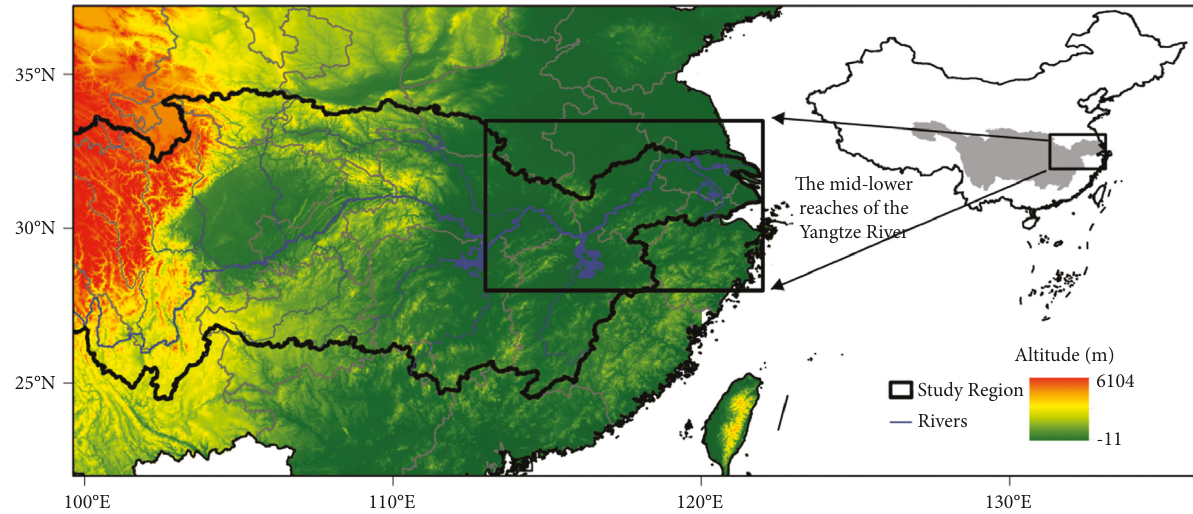
Figure 1: Location of the middle and lower reaches of the Yangtze River